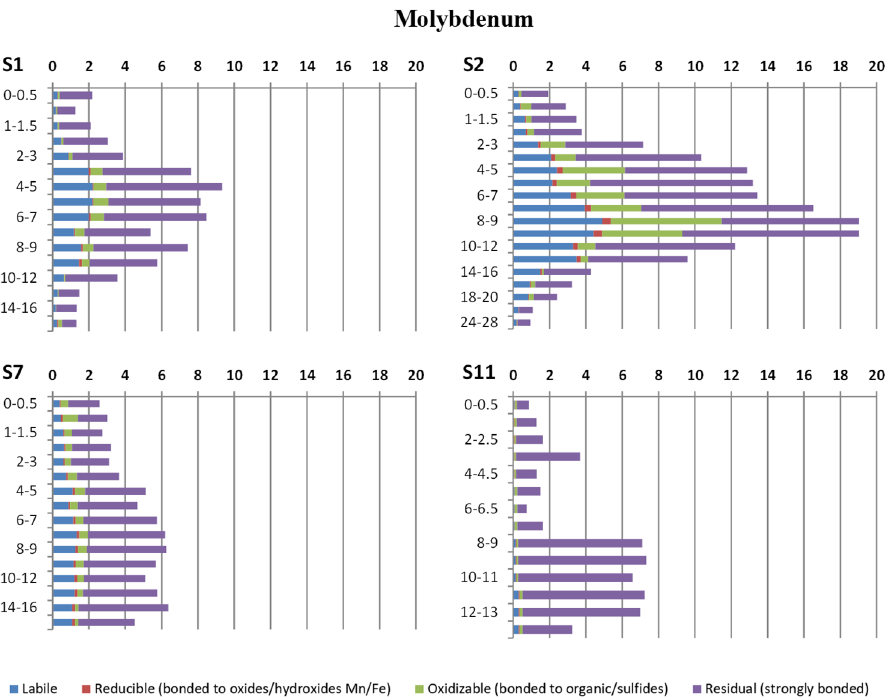
Figure 6. Chemical fractionation of Zn in sediments from the S1, S2, S7, and S11 stations. Horizontal axis: concentration (mg/kg). Vertical axis: core depth (cm).